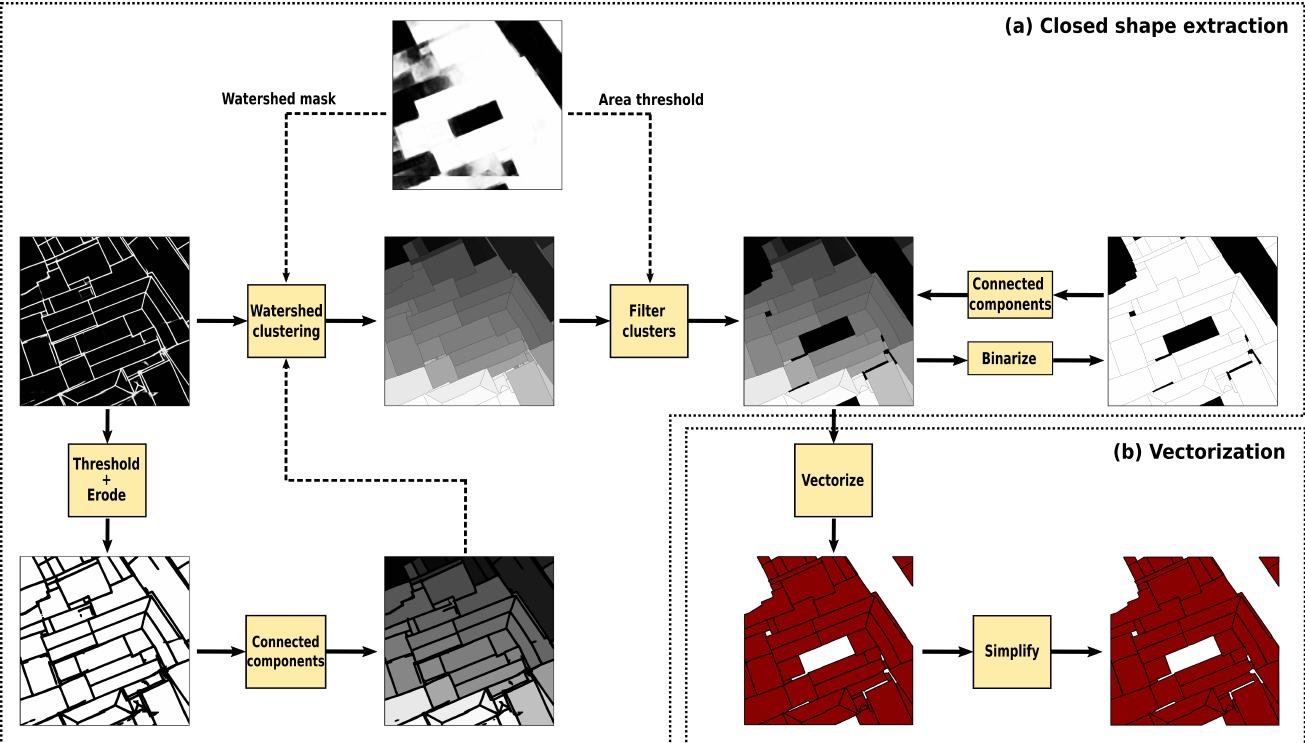
Figure 6. ( a ) Closed shape extraction workflow to convert roof-part object and roof-part edge probability maps to roof-part clusters. ( b ) Vectorization step to convert roof-part clusters into distinct simplified